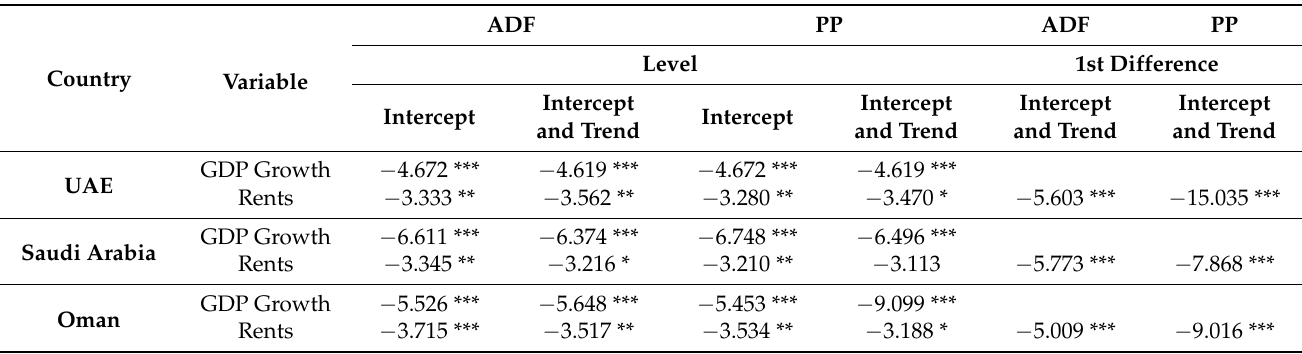
Table 2. Unit root tests.